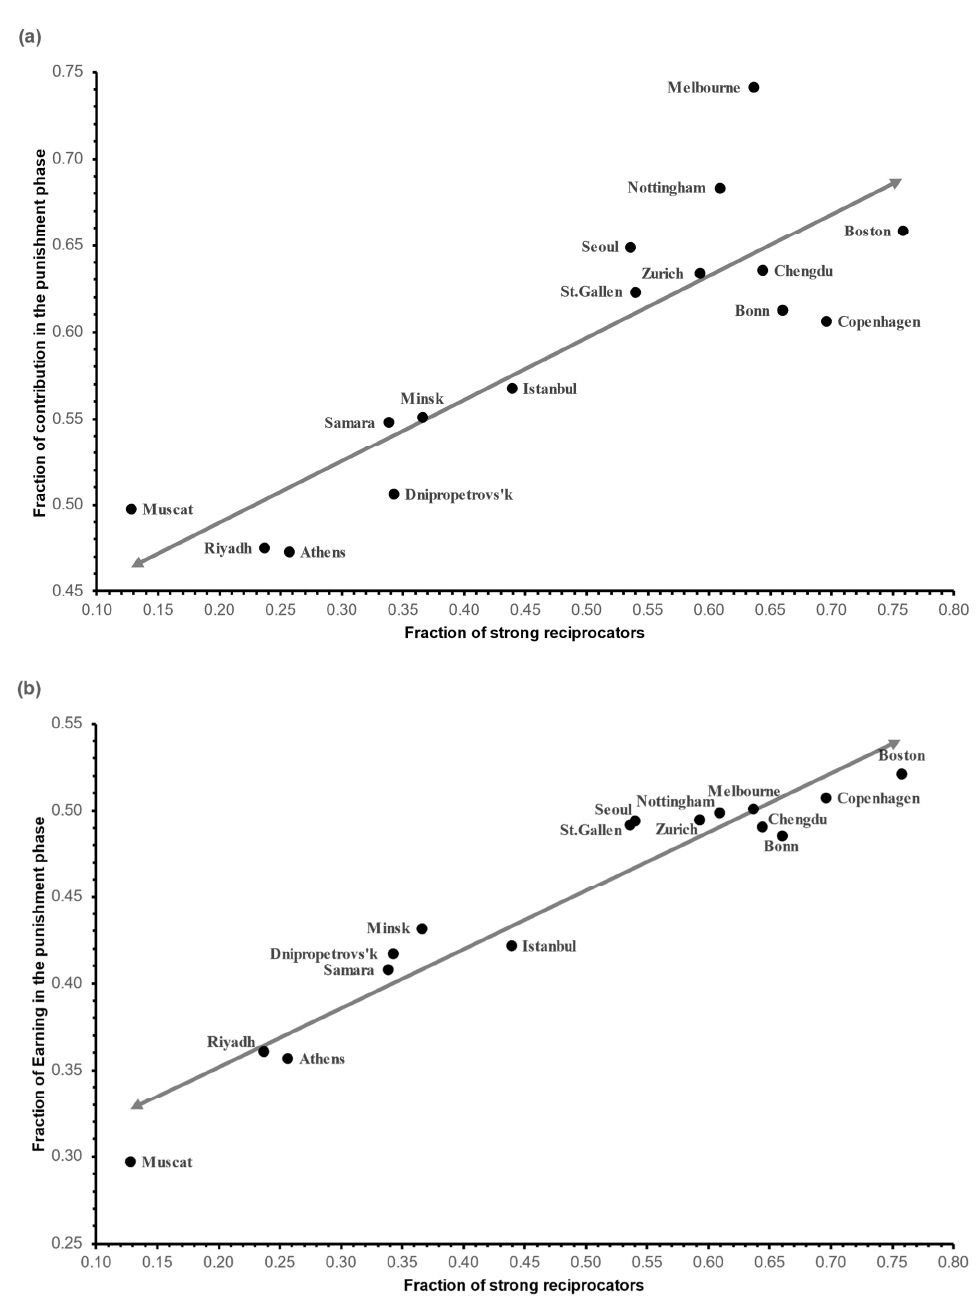
Figure 6. ( a ) Relationship between the fractions of contribution in the punishment phase, and the fractions of strong reciprocators out of the total number of punishers. ( b ) Relationship between the fractions of earnings and the fraction of strong reciprocators out of the total number of punishers.